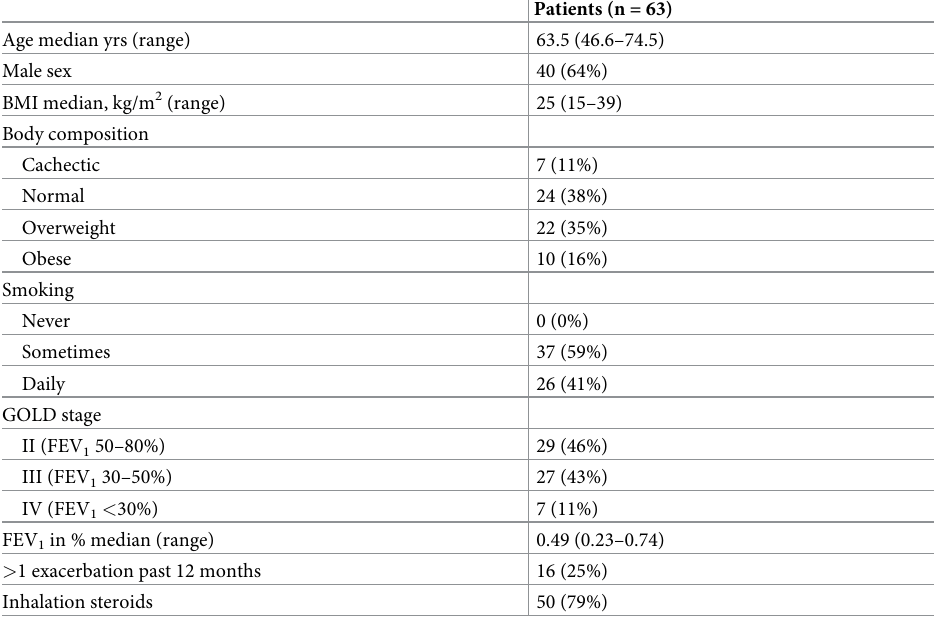
Table 1. Baseline patient